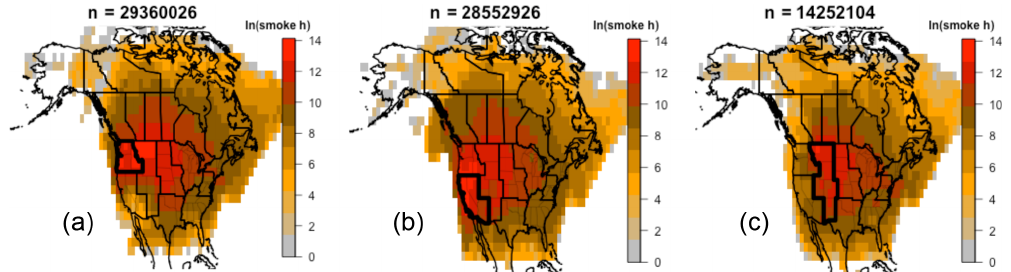
Figure 12. Summertime (June–September) regional smoke hour transport heat maps for the Northwest (a) , Southwest (b) , and Rocky Mountains (c) . Each column shows the count of smoke hours produced by each region on a 2 ◦ by 2 ◦ grid with a consistent color bar for all three regions. The grid spans 18–180 ◦ W and 18–90 ◦ N, a domain covering all five sectors where HMS analyzes smoke plumes (only a subset plotted). Shaded values are the natural log of the number of smoke hours in each grid cell (min of 1, max of 1.2 million). All figures were generated using GDAS1 meteorology